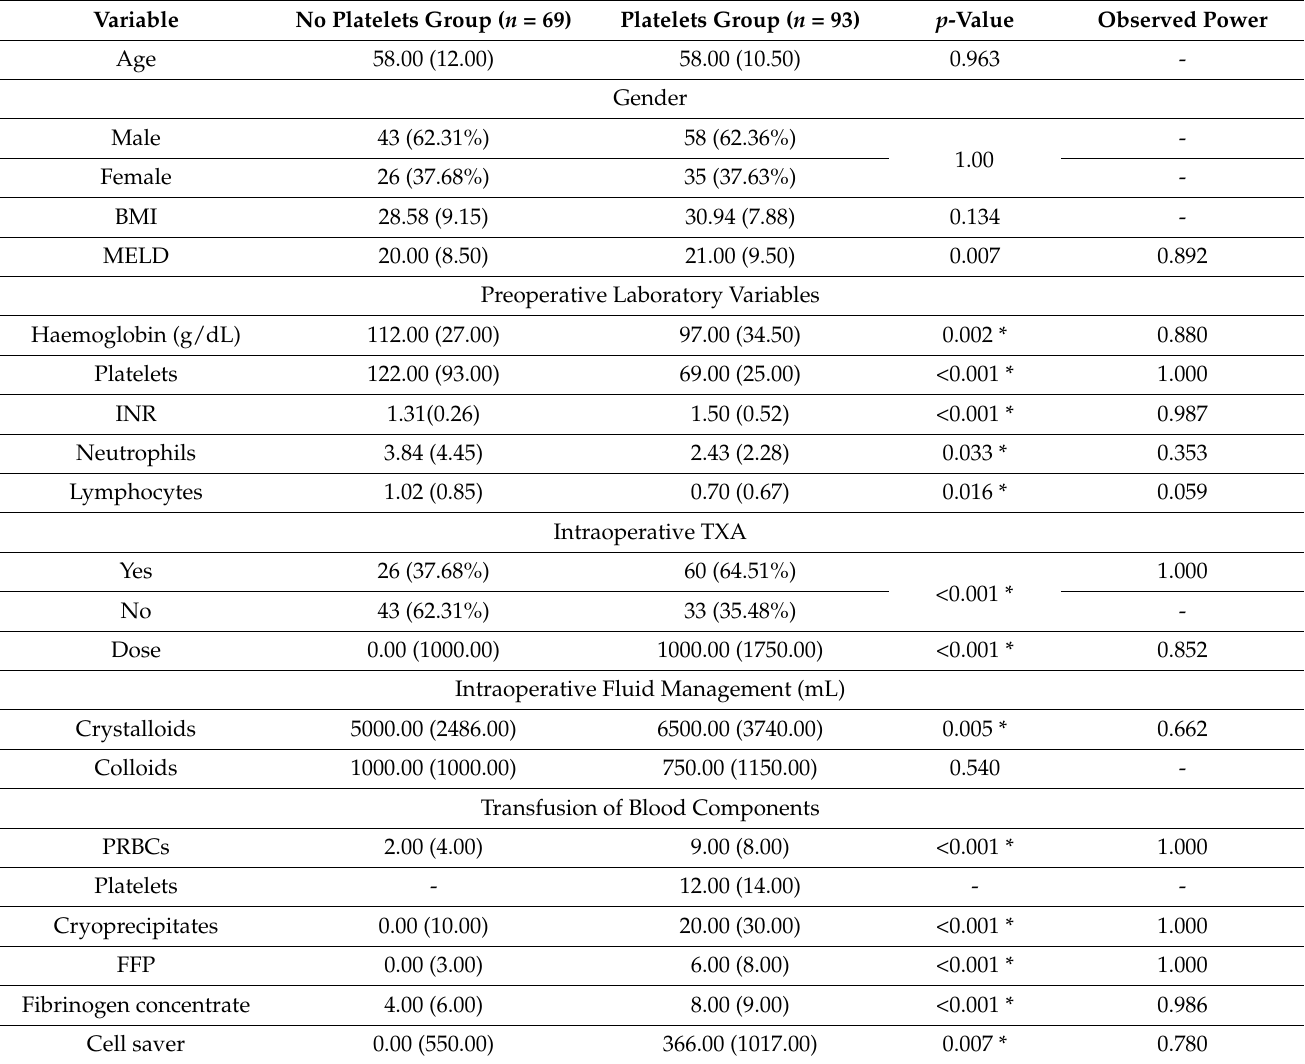
Table 4. Demographics and clinical characteristics of LT patients categorised by intraoperative transfusion of